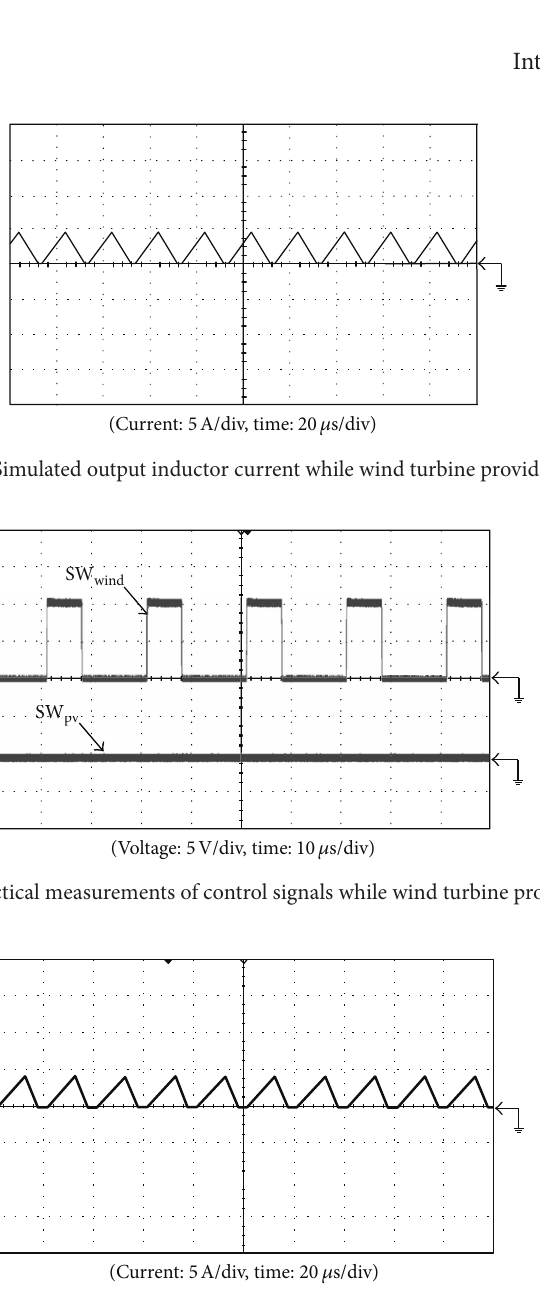
Figure 13: Measured output inductor current while wind turbine provides 350